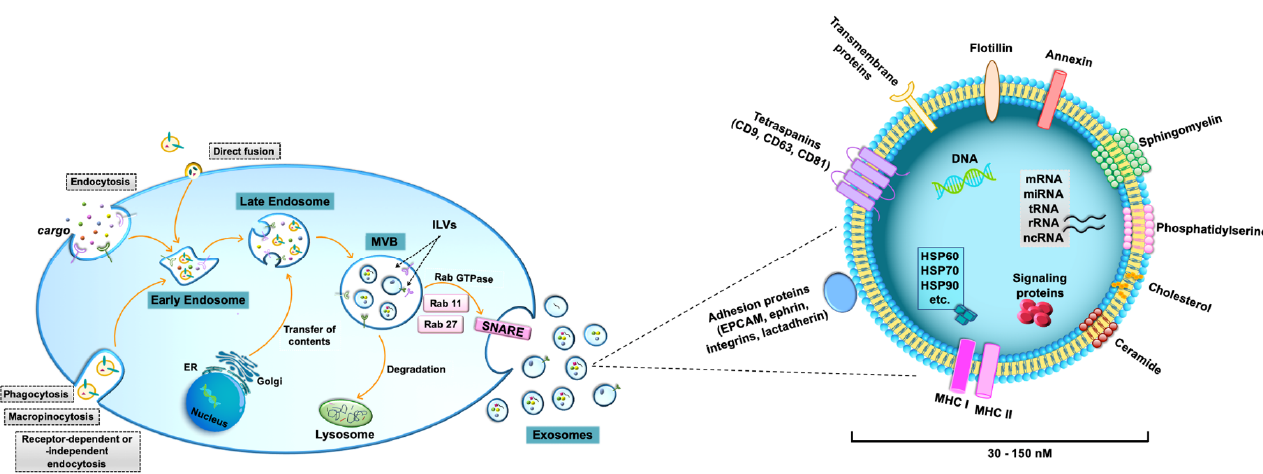
Figure 2. Biogenesis and composition of exosomes. Biogenesis of de novo exosomes starts from the formation of early endosomes by endocytosis of extracellular components. Early endosomes germinate inward, forming late endosomes and subsequently late endosomes mature as multivesicular bodies (MVBs) that contain intraluminal vesicles (ILVs). After fusion of MVBs with the plasma membrane, mature exosomes are released into the extracellular space by exocytosis. Exosome secretion is mediated by Rab GTPase proteins, such as Rab 11 and Rab 27, which control MVBs trafficking, as well as their binding to the plasma membrane and to soluble NSF-attachment protein receptor (SNARE) complexes. Additionally, recycled exosomes, which enter cells through several possible mechanisms, including macropinocytosis, phagocytosis, direct fusion, or caveola-, clathrin- or lipid raft-dependent endocytosis, participate in exosome assembly and cargo remodeling. Alternatively, both MVBs and recycled exosomes undergo fusion with lysosomes for degradation and release of their components into the cytosol. Exosomes are nano-sized vesicles, ranging from 30 to 150 nm. Their lipid bilayer membrane contains sphingomyelin, phosphatidylserine, cholesterol, and ceramide. Exosome surface proteins include specific tetraspanins (CD9, CD63, and CD81), adhesion proteins (e.g., EPCAM, ephrin, integrins, and lactadherin), growth factors, major histocompatibility complex (MHC) class I or class II molecules, annexin, and flotillin. Exosome cargo contains specific proteins, including cell signaling proteins, heat shock proteins (i.e., HSP60, HSP70, HSP90), and DNA and RNA molecules, such as microRNA (miRNA), messenger RNA (mRNA), transfer RNA (tRNA), ribosomal RNA (rRNA), and non-coding RNA (ncRNA).